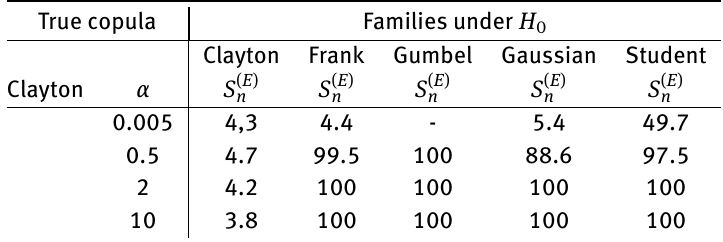
Table 1: Percentage of rejection at 5 % , based on 1000 replicates, of the null hypothesis of belonging to a given family of copu- las with N = 5000, n = m = 1000, r = 4 and p = 2 .